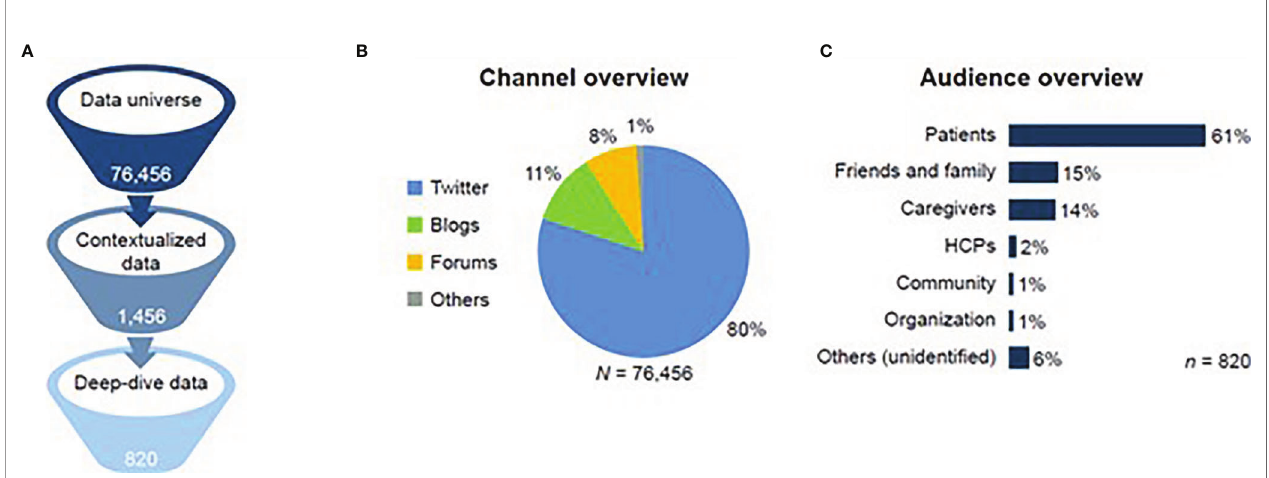
FIGURE 2 | Flow diagram of social media post-selection and demographics of channel and audiences. (A) Data fi ltering stages. (B) Share of data universe by social media channel. (C) Share of deep-dive data by audience type. HCP, healthcare professional.